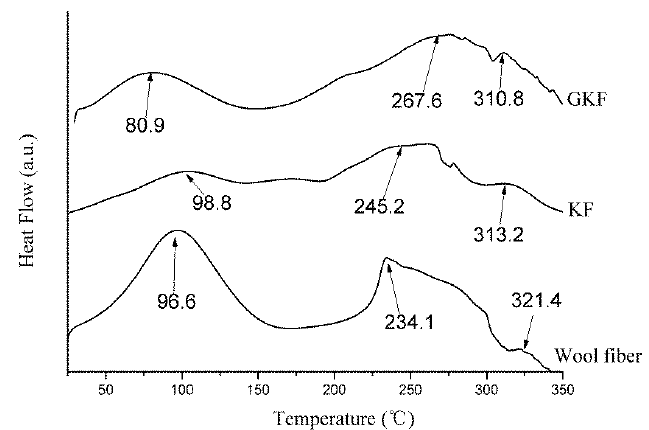
Figure 8. Differential scanning calorimetry (DSC) thermograms of wool fibers and regenerated keratin films.